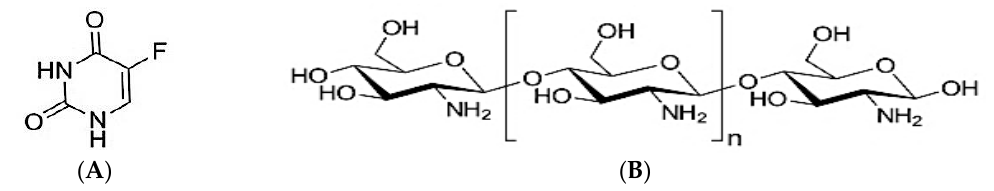
Figure 1. Chemical structure of 5-FU ( A ) and chitosan ( B ).